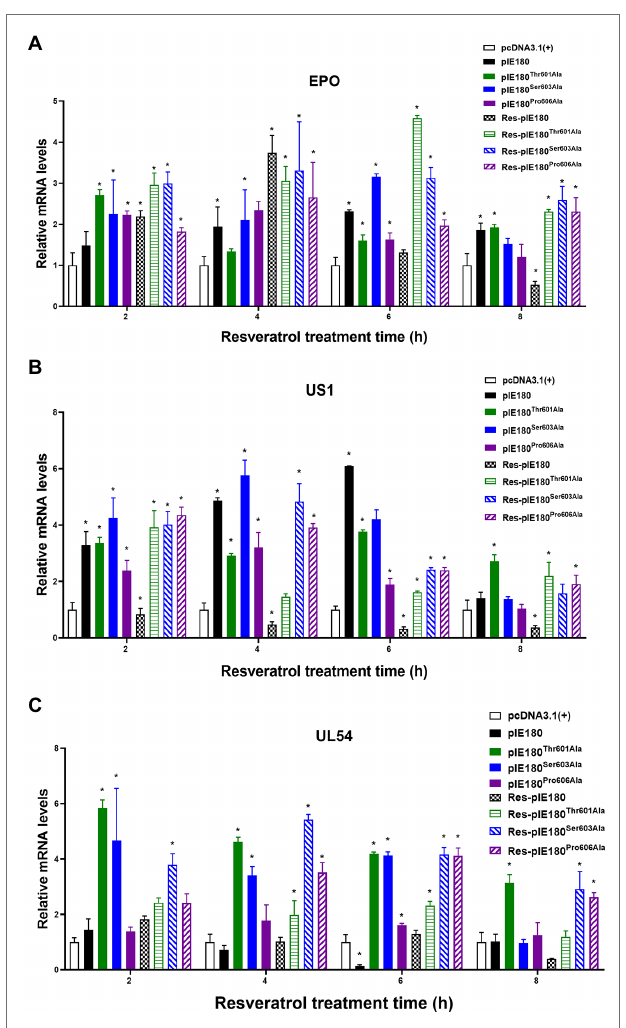
FIGURE 8 | Effect of Res on early gene expression after transfection with pcDNA3.1(+)/pIE180/pIE180 Thr601Ala /pIE180 Ser603Ala /pIE180 Pro606Ala . (A) Effect of Res on early gene (EPO) expression. (B) Effect of Res on early gene (US1) expression. (C) Effect of Res on early gene (UL54) expression. * p < 0.05 represents a significant difference compared to the pcDNA3.1(+) group ( n =